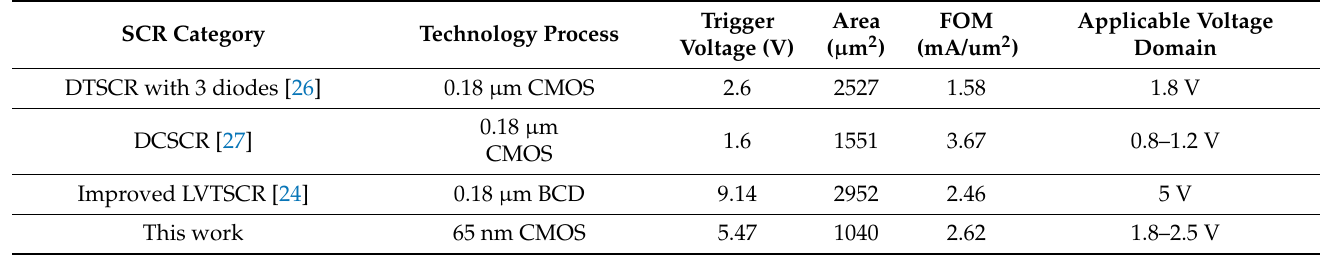
Table 2. Comparison among the DTSCR, DCSCR, improved LVTSCR, and the proposed